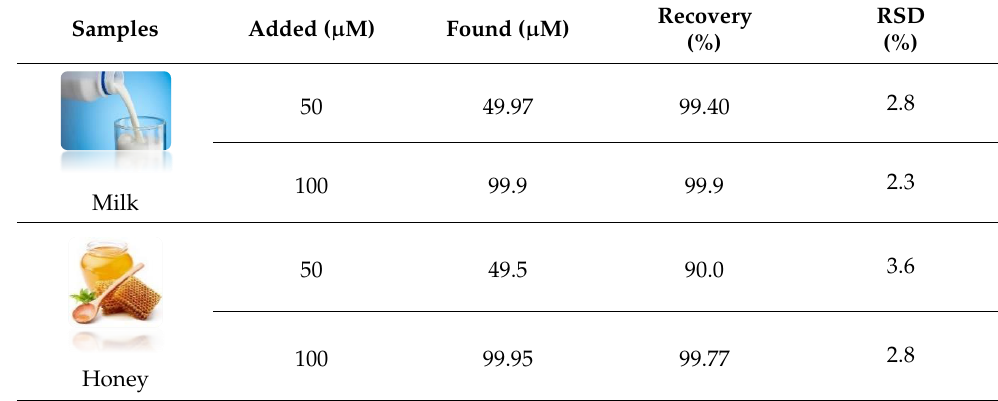
Table 2. Determination of CAP in milk and honey samples using the Sr@Se/PGCN/GCE sensor. Samples